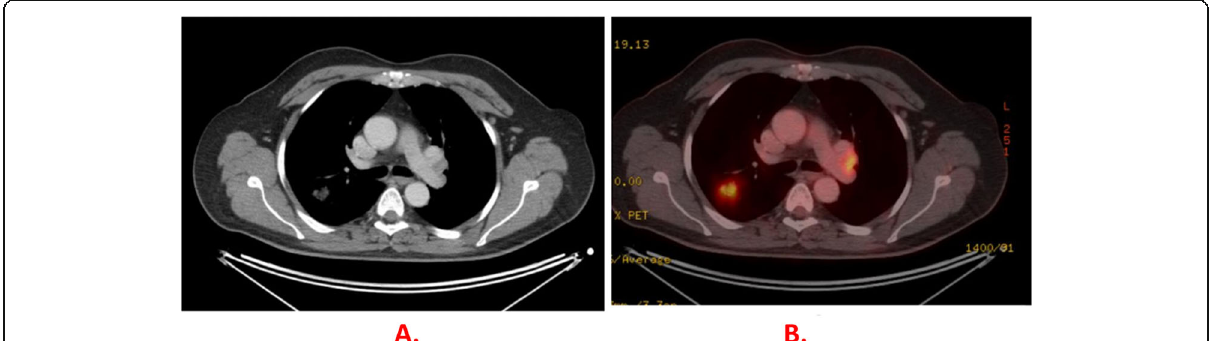
Fig. 2 A 58-year-old male patient, pathologically proven having NSCLC; the initial staging revealed the following: a CECT showed only ipsilateral hilar LNs, b PET/CT detected contralateral hilar LN with high FDG (SUV = 6) and upstaged the patient from N2 to N3